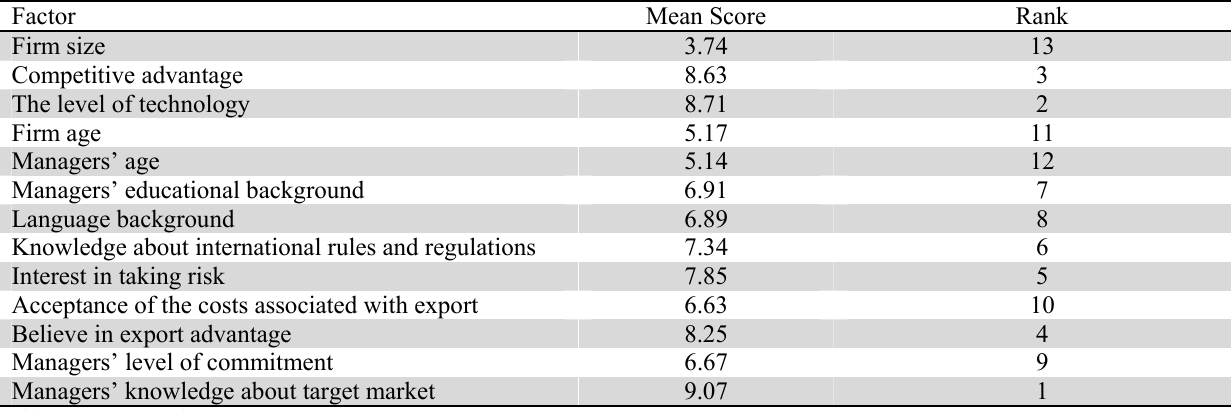
The summary of freedman